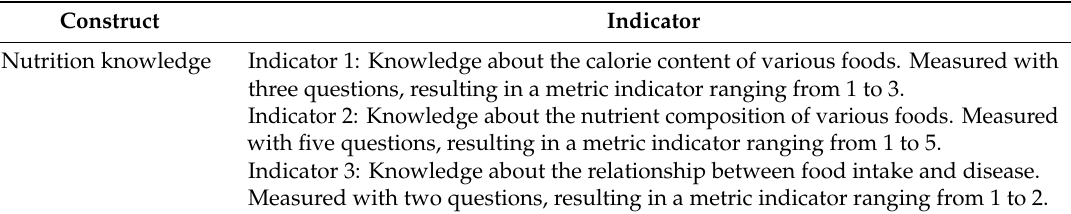
Table 2. Overview of the constructs and their indicators in the